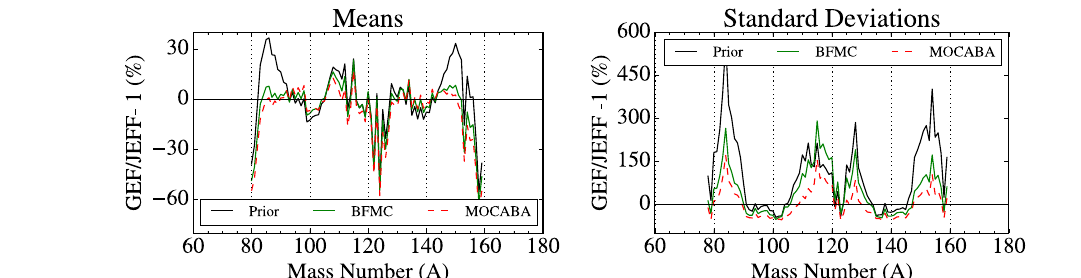
Fig. 9. Correlations between the independent FYs of U-235 and Pu-239.